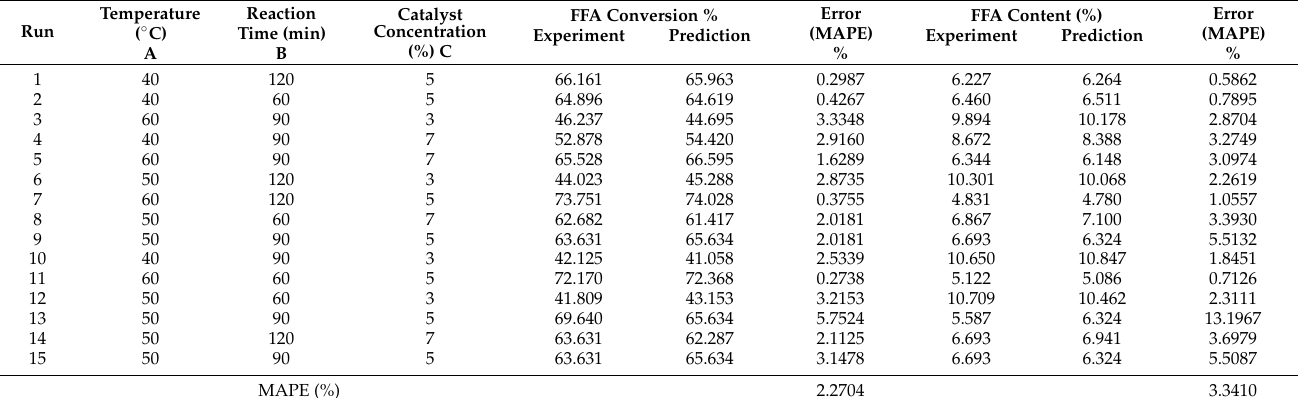
Table 3. The Box–Behnken Response Surface Design and Corresponding Response